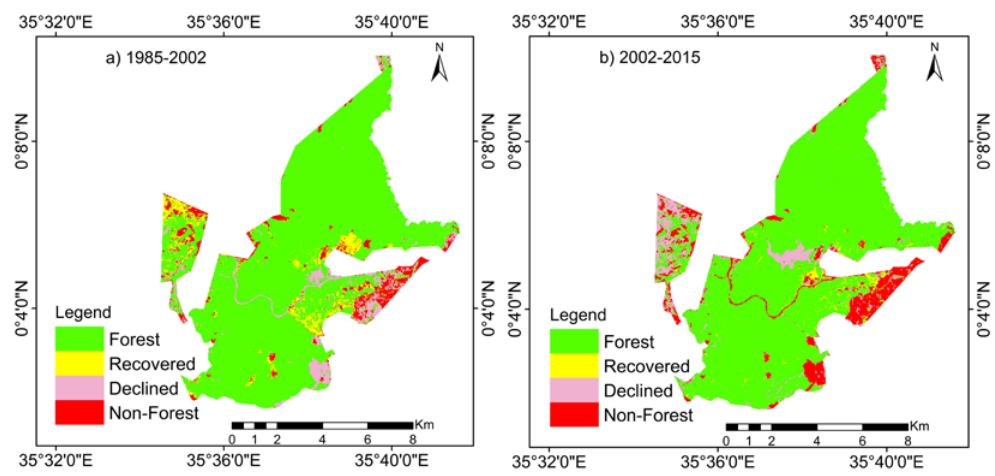
Figure 4. Forest-cover changes in the Chemususu Forest Block in the ( a ) 1st and ( b ) 2nd periods.